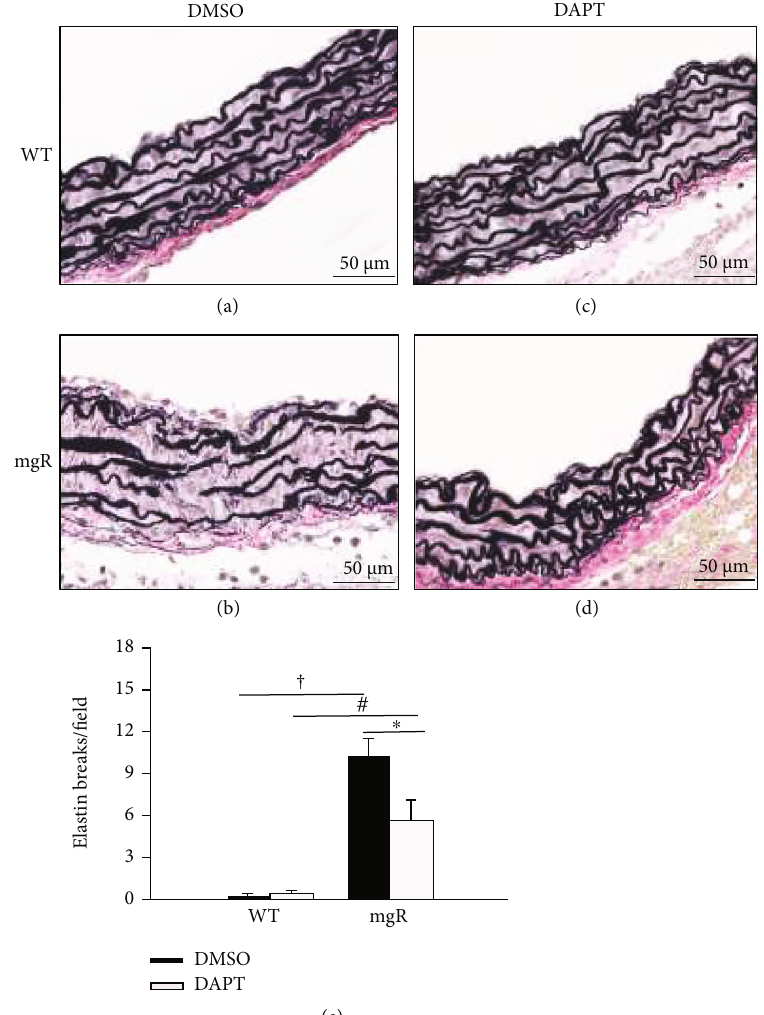
Figure 3: DAPT treatment, which inhibits Notch activation, prevented elastin fragmentation. (a – d) Verhoe ff -van Gieson (VVG) staining of elastic fi bers of the ascending aorta from WT and Fbn1 mgR/mgR (mgR) mice at PD42 treated with DMSO (vehicle control) or DAPT; WT mice treated with DMSO (a) or DAPT (c); mgR mice treated with DMSO (b) or DAPT (d) at PD42. (e) Elastin breaks per fi eld under 40x magni fi cation in DMSO- or DAPT-treated WT and mgR mice ( n = 5 aorta/groups). ∗ P < 0 : 05 , ǂ P < 0 : 01 , and † P < 0 : 001 , ANOVA with Tukey-Kramer post hoc